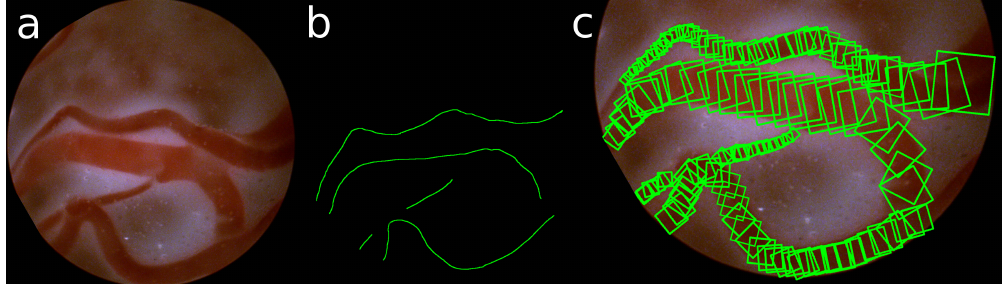
Figure 5. ( a ) Sample image; ( b ) annotated center line; ( c ) selection of annotated